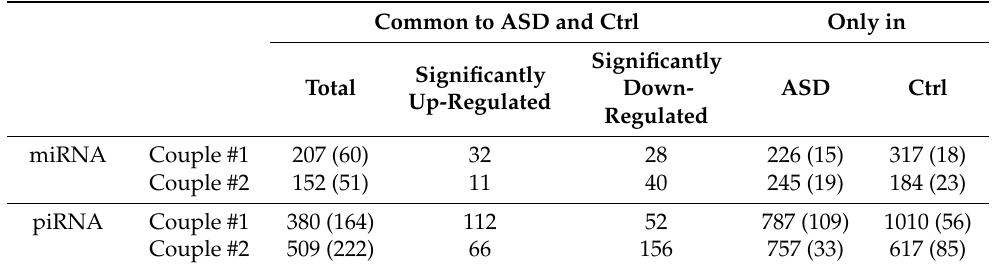
Table 2. MiRNAs and piRNAs count in the couples of siblings. Within the parentheses are signifi- cantly different data (Fisher tests, p < 0.05); Ctrl, control. Common to ASD and Ctrl Only in Significantly Significantly Down- ASD Ctrl Total Up-Regulated Regulated miRNA Couple #1